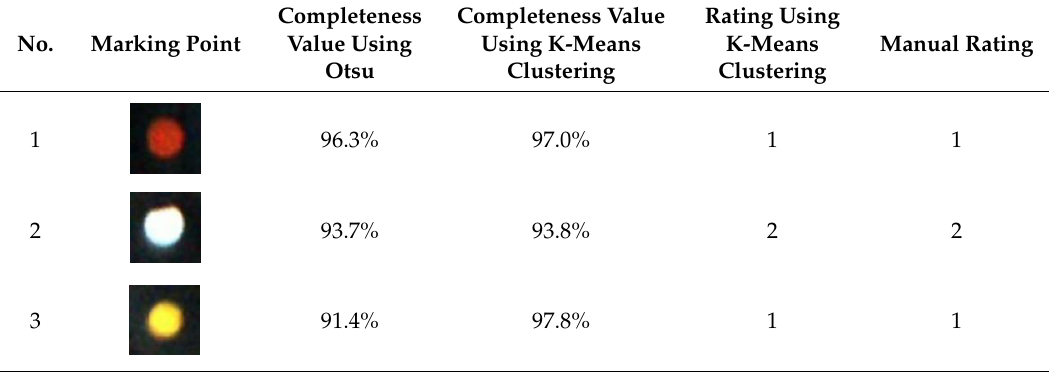
Table 3. The results of the completeness rating for some marking points.